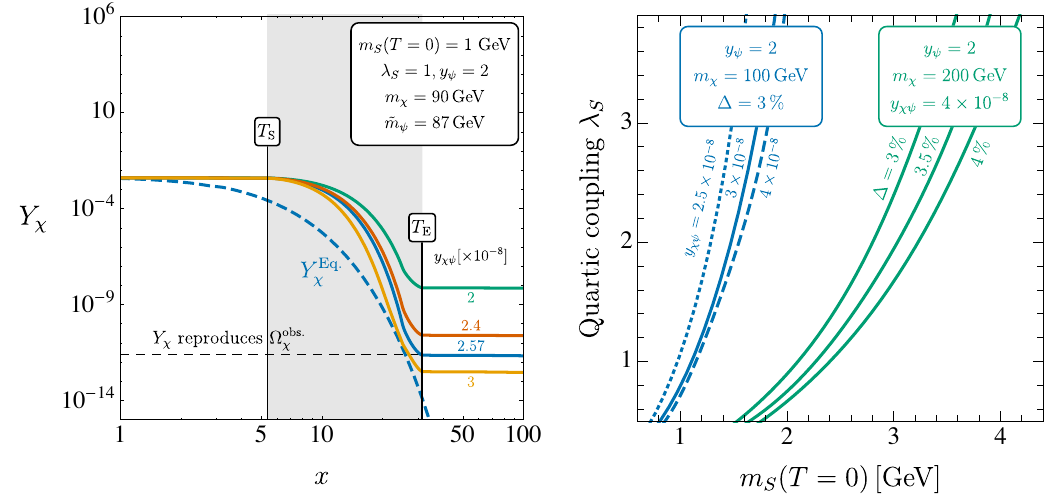
Figure 11 . Left: the evolution of the yield for di(cid:11)erent values of y (cid:31) (solid lines). The equilib- rium abundance of (cid:31) is dashed blue while the yield required to reproduce the observed DM relic abundance is black dashed. Right: the m S ( T = 0) and (cid:21) S 4 which reproduce the observed DM relic abundance for di(cid:11)erent parameter choices. For the dotted line freezes-out before T E , while for the dashed line (cid:31) returns to